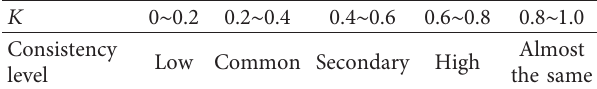
Table 5: Classification of Kappa